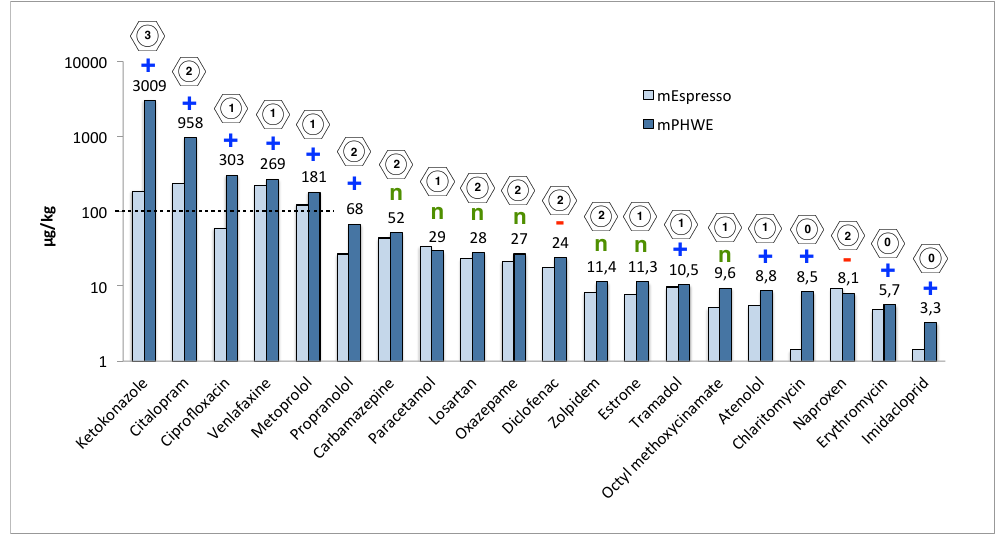
Figure 4. Concentrations in µ g / kg of 23 APIs in lyophilized sewage sludge from Kristianstad STP determined using the Espresso method (light blue) and the PHWE method (dark blue). The APIs are listed in descending order of concentration ( PHWE method ) together with the charge and the number of aromatic ring structures of the compound in